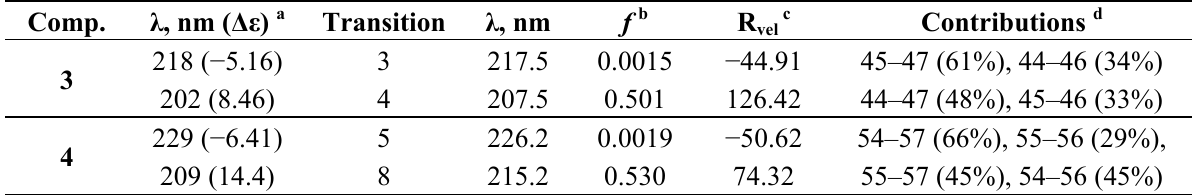
Table 2. Properties of selected transitions and their contribution to the CD spectra of dinitrile 3 and diacid 4 ( trans-trans conformer) calculated at the B3LYP/aug-cc-pVDZ level .